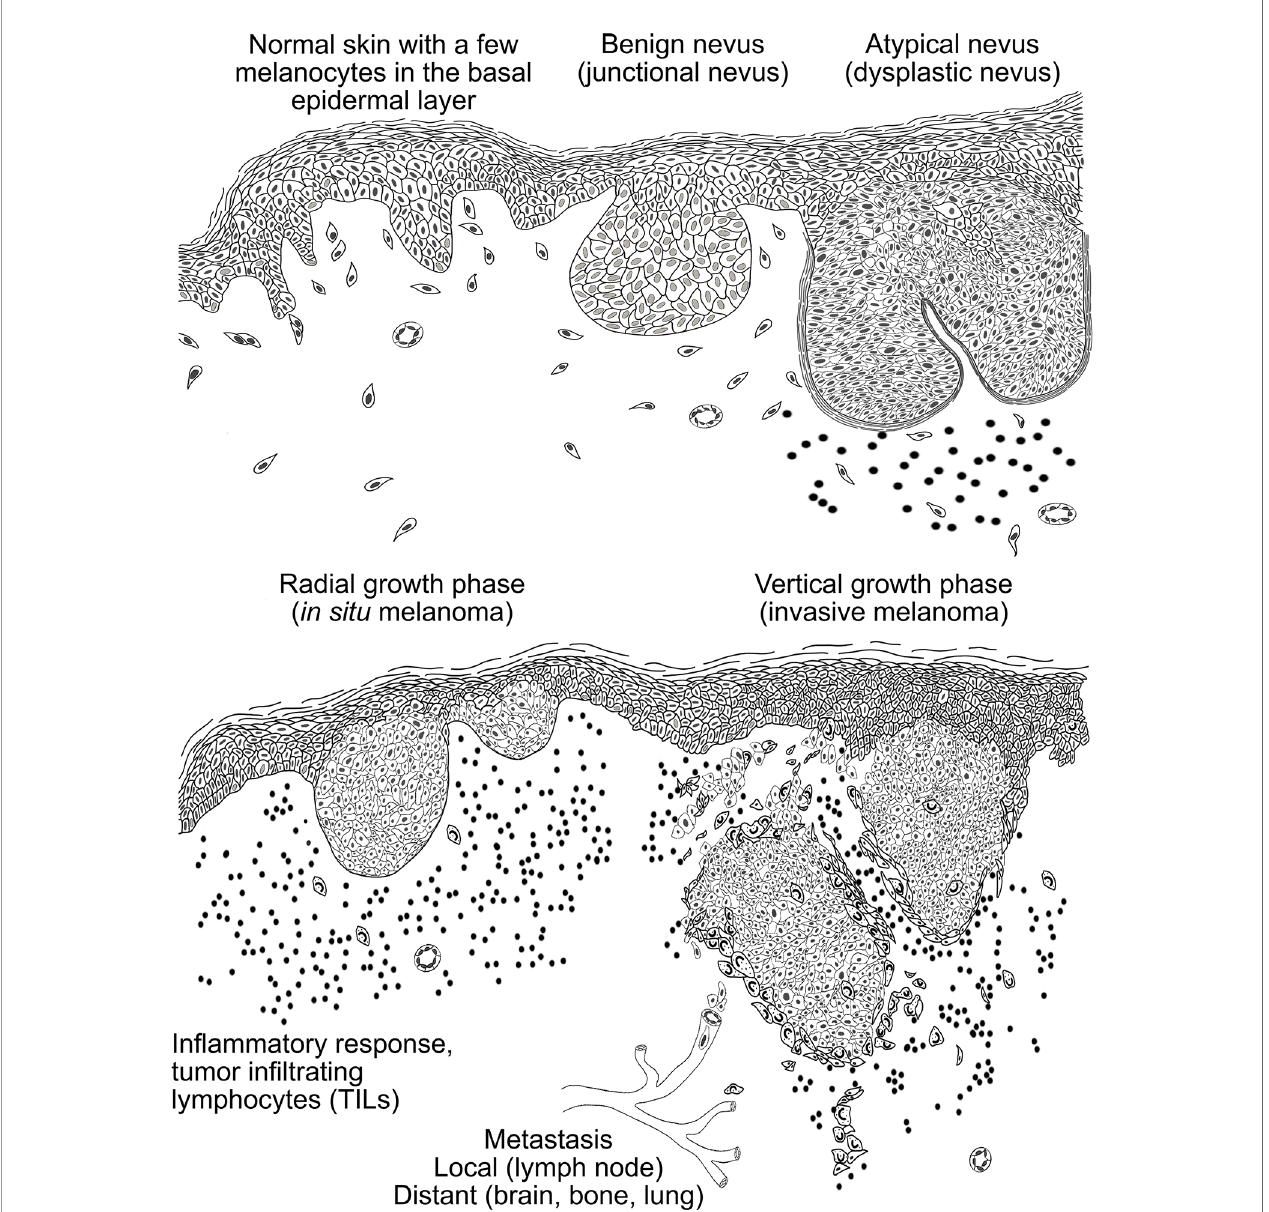
FIGURE 2 | A schematic presentation of the histopathogenesis of the melanocytic tumors. In normal skin, melanocytes are scattered along the basal cell layer. Melanocytes accumulation leads to the formation of benign nevi that can reside in the epidermis (junctional nevus), in the dermis (intradermal nevus) or nevus cells can be assembled in both (compound nevus). In dysplastic nevus melanocytes exhibit cell hyperplasia and show cytological and architectural atypia. Moreover, lymphocyte in fi ltration around the nevus is typical in dysplastic nevi. In the radial growth phase (RGP) melanoma is still restricted to the epidermis by basement membrane and associates with high lymphocyte in fi ltration. When melanoma cells start to invade through the basement membrane into the dermis, melanoma has reached the vertical growth phase (VGP). In this stage the melanoma cells are capable of metastasizing via blood and lymphatic capillaries to local lymph nodes and distant